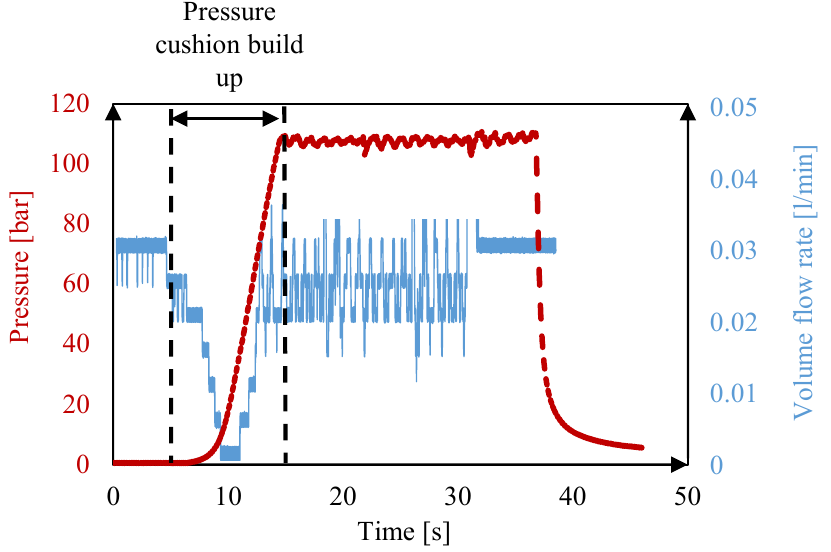
Figure 18. Pressure and volume flow progression curve for in contact lubricated strip drawing test.